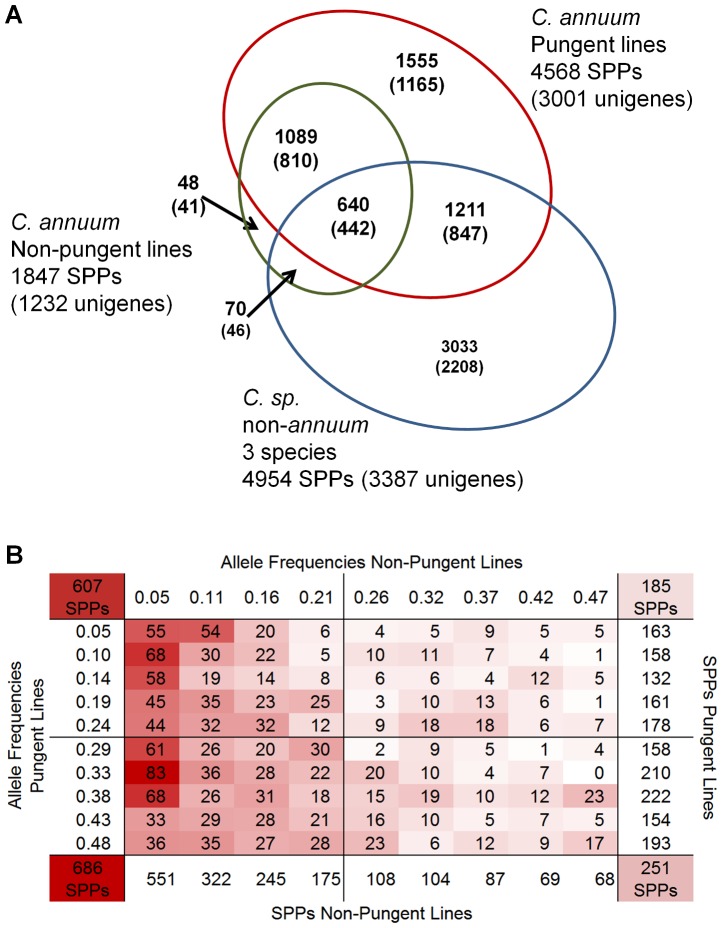
Polymorphisms among 19 non-pungent, 21 pungent C. annuum and 3 non-annuum lines.(A) Venn diagram depicting the number of SPPs and unigenes (shown in parentheses) polymorphic within each group out of 9,272 SPPs within 5,712 unigenes having >2 minor alleles across the 43 lines. (B) Allele frequency matrix for 1729 informative SPPs among pungent and non-pungent C. annuum lines. Numbers indicate SPPs found at each minor allele frequency pair. At the corners are shown the total number of SPPs for minor allele frequencies pairs divided by 0<0.25 and 0.25<0.5. At left and bottom are shown total SPPs at each minor allele frequency for pungent and non-pungent lines respectively.